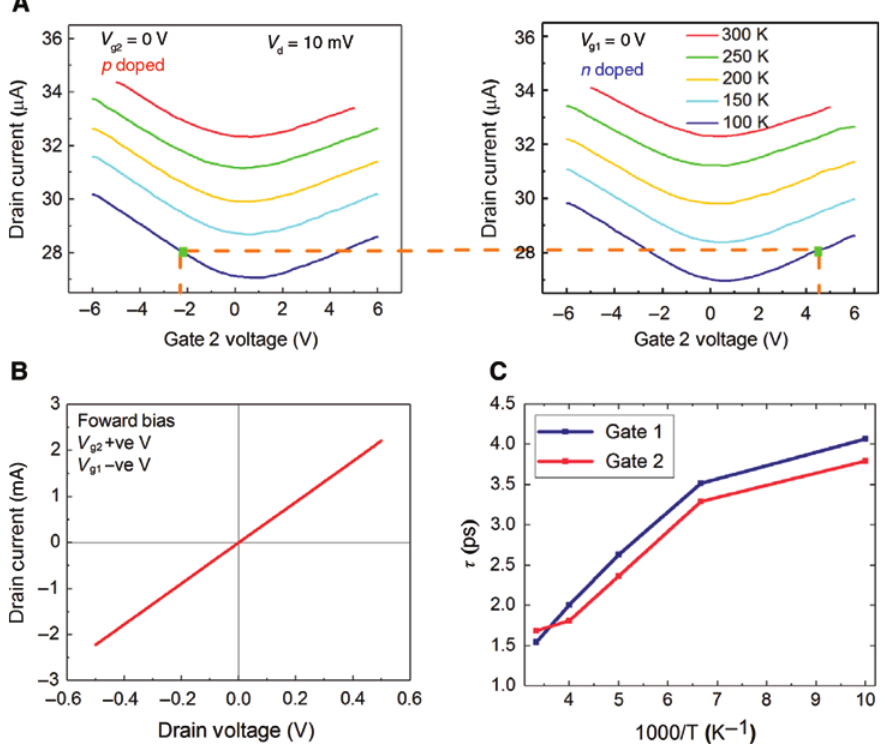
Figure 5: The slope of the ambipolar curves in (A), corresponding to the transconductance in proportion to the carrier momentum relaxation time, gets steeper with decreasing the temperature. (A) Measured ambipolar current-voltage characteristics of device 1 for G1 and G2 voltages with V for symmetric electron/hole injections. (B) Measured uniform drain current-drain voltage characteristics at 300 K. (C) Temperature depend- ence of carrier momentum relaxation time ( τ ) for device